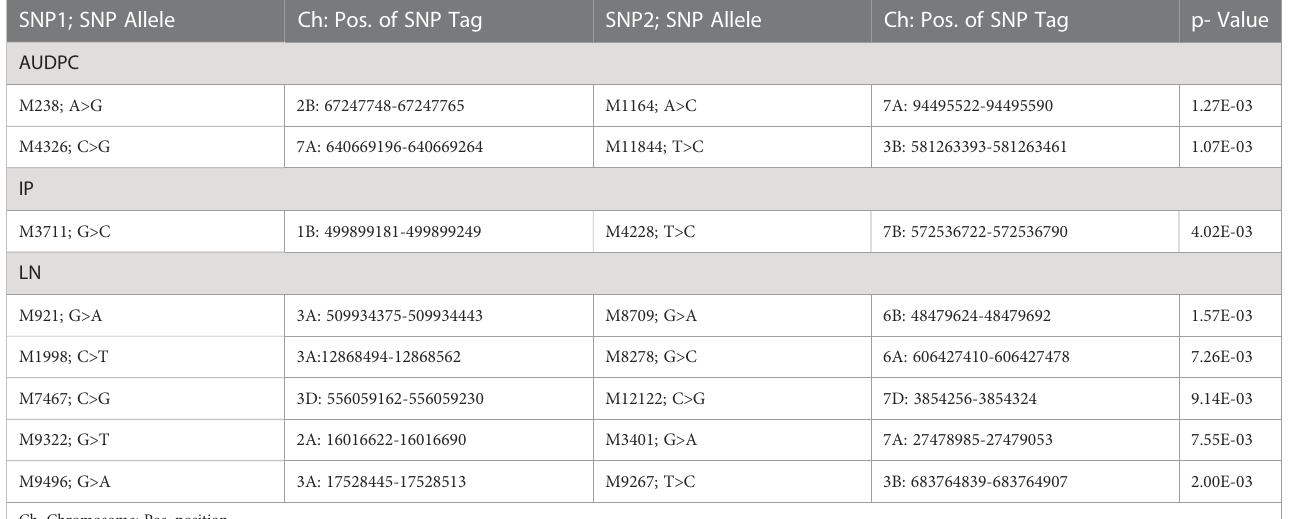
TABLE 3 Epistatic interactions for different traits in three